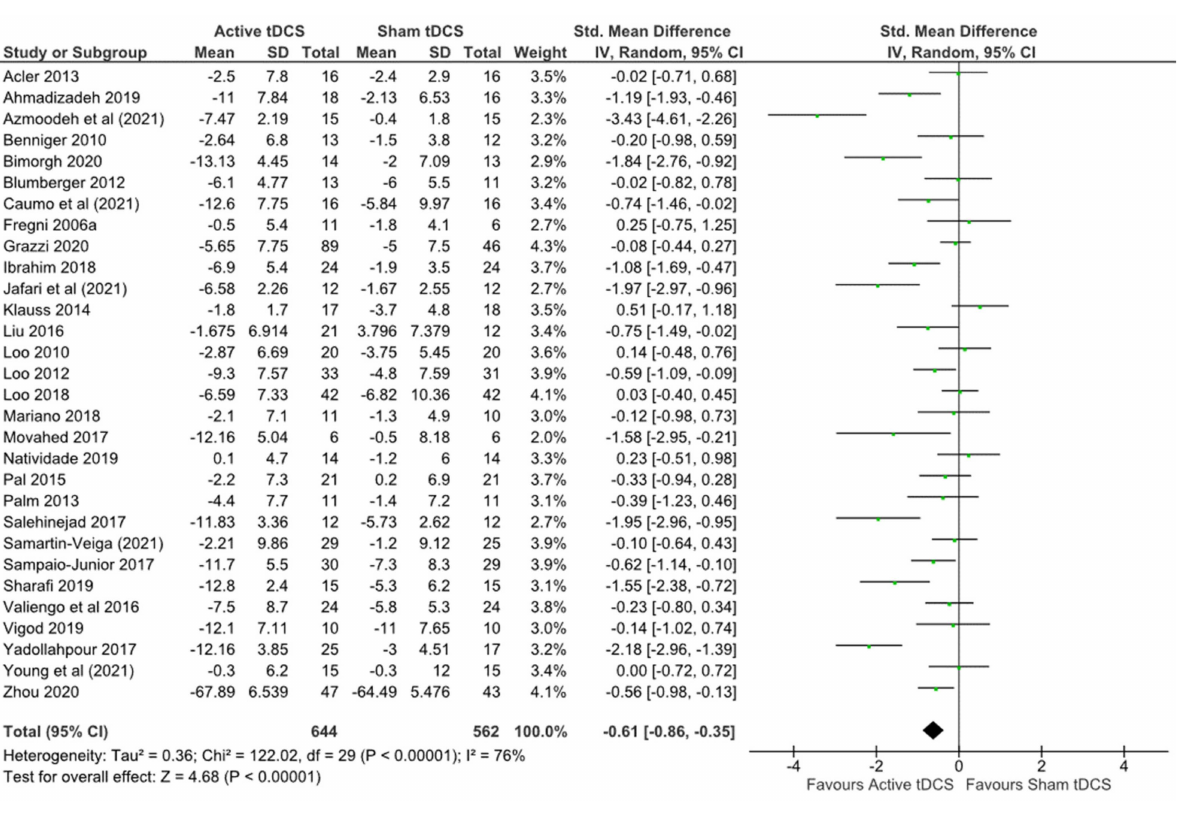
Figure 4. Forest plot depression.